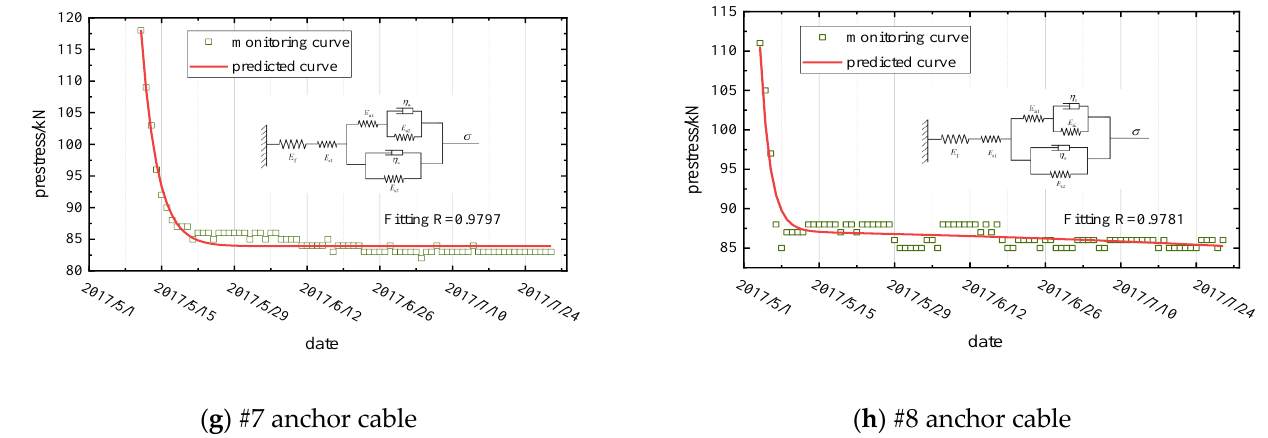
Figure 11. Comparison of monitoring and prediction prestress of the anchor cables. The comparative data between the actual loss ratio and the calculated loss ratio caused by deformations of the anchorage device and the waist beam are shown in Figure 12. The actual prestress loss ratios of the #1~#6 anchor cables were less than the calculated prestress loss ratios, and the model calculation tended to be conservative. The calculated value of the #7 – #8 anchor cable prestress loss ratios were the same as the actual monitoring values. The reason is that when the anchor cables are tensioned and locked, the operation of workers is not standard, which causes the actual loss ratios of the #7 – #8 anchor cables to increase. The instantaneous prestress loss ratios calculated by the model of the #1 – #8 anchor cables were 35.2%, 36.1%, 42.8%, 40.4%, 42.8%, 40.4%, 53.0%, and 55.0%, respec- tively, which are consistent with the research conclusion of Tang [52]. Tang indicated that when the anchor cable was tensioned to locked, the maximum loss ratio of prestress caused by the anchor device and the waist beam was 53.4%, and the minimum loss ratio was 24.5%. Figure 12. Comparison of actual and calculated prestress loss ratio of the anchor cable. The relationship curve between creep loss ratio and time is shown in Figure 13. The prestress loss ratio increased rapidly first, and then remained basically unchanged over time. It shows that the creep effect will end at a certain moment, and after that, with the further delay of time, the prestress loss of the anchor cable disappears.